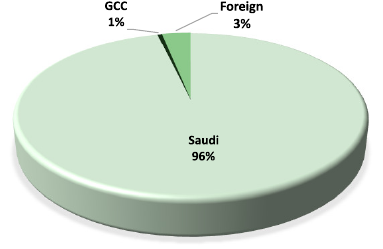
Figure 1. Investor Ownership in Saudi Stock Exchange